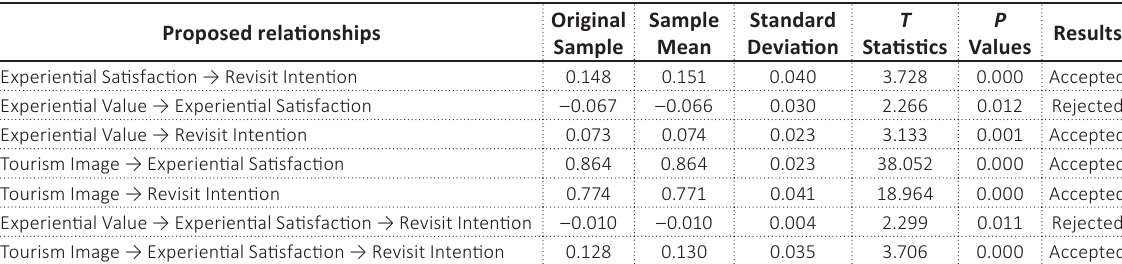
Table 3. Direct and indirect